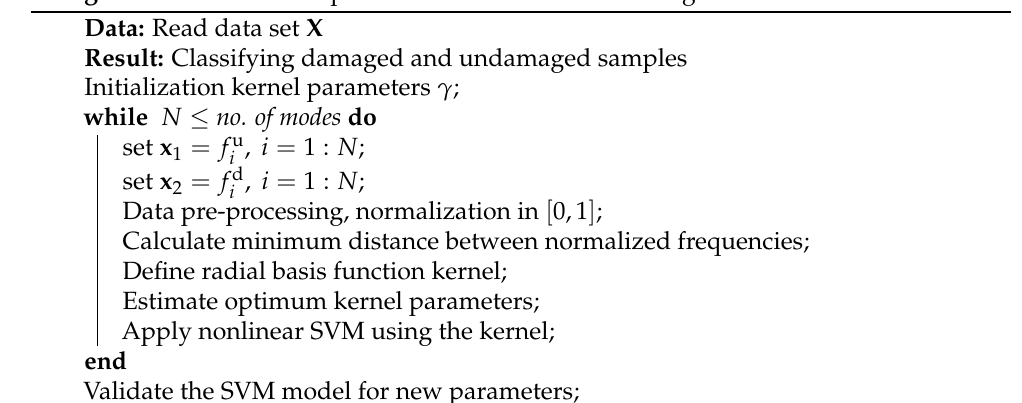
Algorithm 1: Numerical procedure for classification using nonlinear SVM.